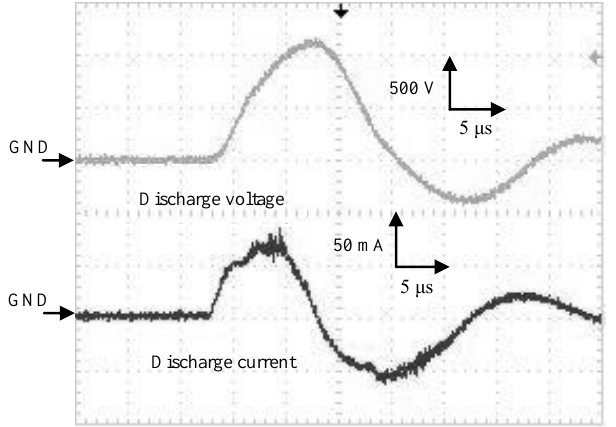
Figure 5. Discharge voltage and corresponding discharge current by a high voltage